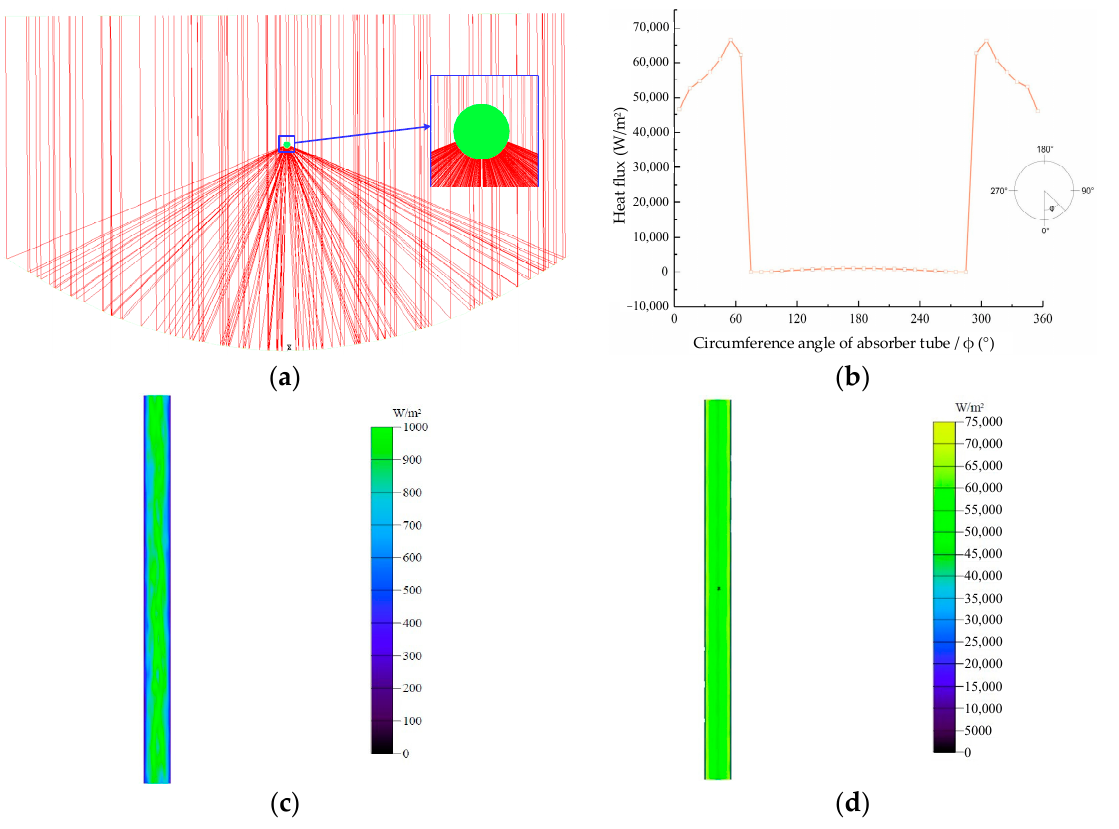
Figure 7. ( a ) PTC solar ray tracing results (including an enlarged view of the absorber tube), ( b ) average circumferential solar radiation at the cross-section, ( c ) Upper surface solar radiation distribution along the radial direction, ( d ) lower surface solar radiation distribution along the radial direction.